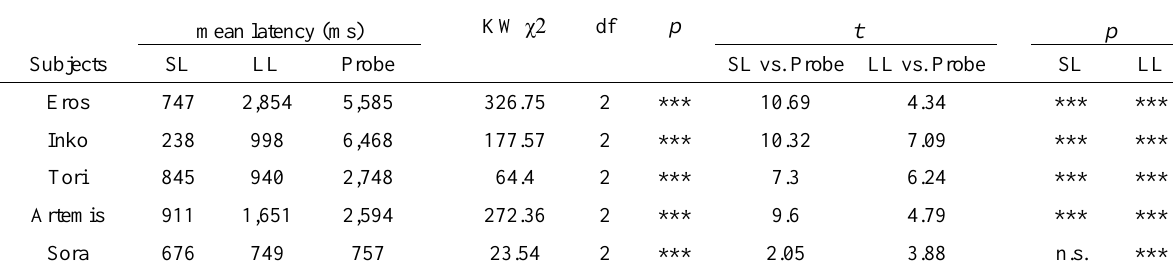
Difference of Response Latency Between Training and Probe Stimuli in Two Template Task mean latency (ms) KW